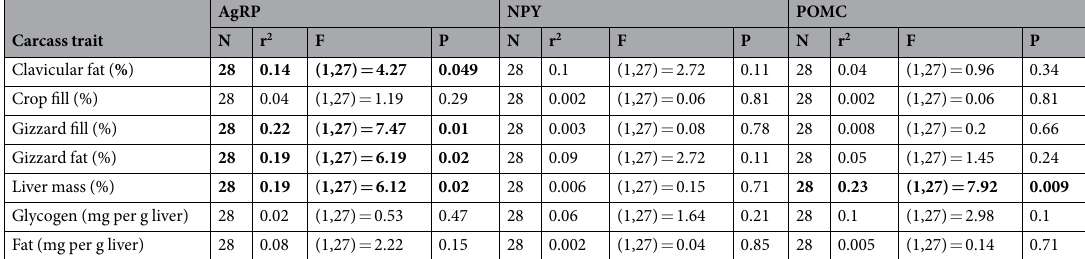
Table 1. The results of individual regression analyses of carcass traits with relative basal hypothalamic gene expression levels. Significant associations are shown in bold.